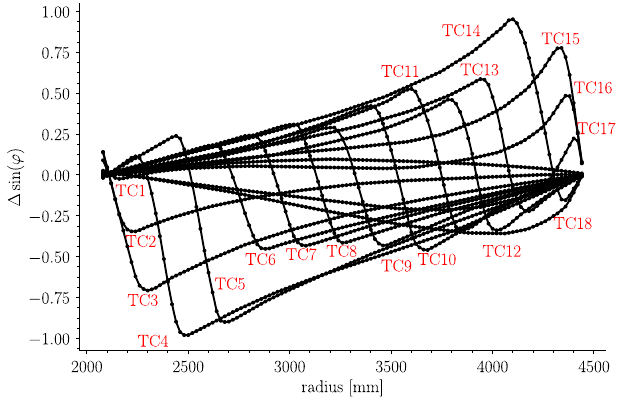
FIG. 7. Turn separation among subsequent orbits measured at the probe RRL (minimum 4.6 mm and maximum 22.9 mm).